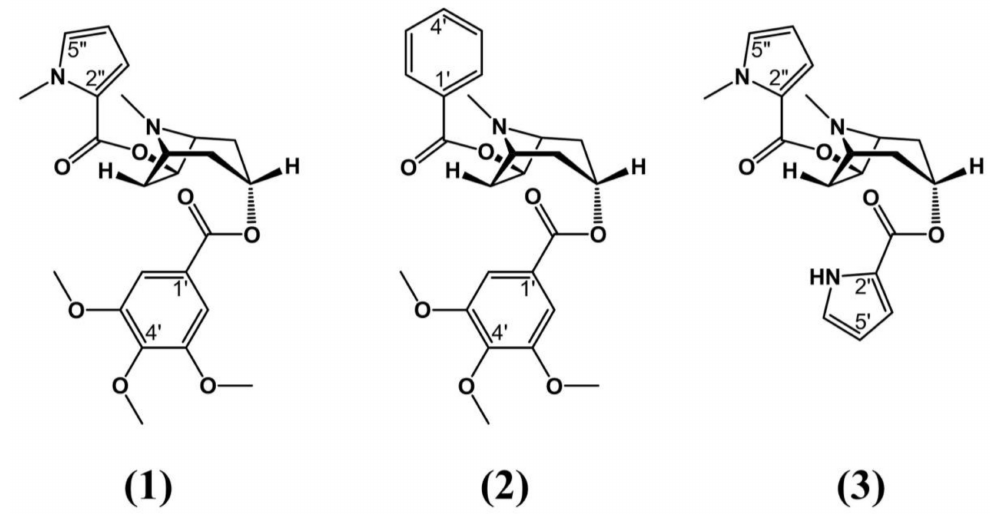
Figure 2. Example of novel tropane alkaloids found in extracts of E. vacciniifolium. Structural data was determined using high-resolution electrospray ion cyclotron resonance mass spectroscopic analysis [57].